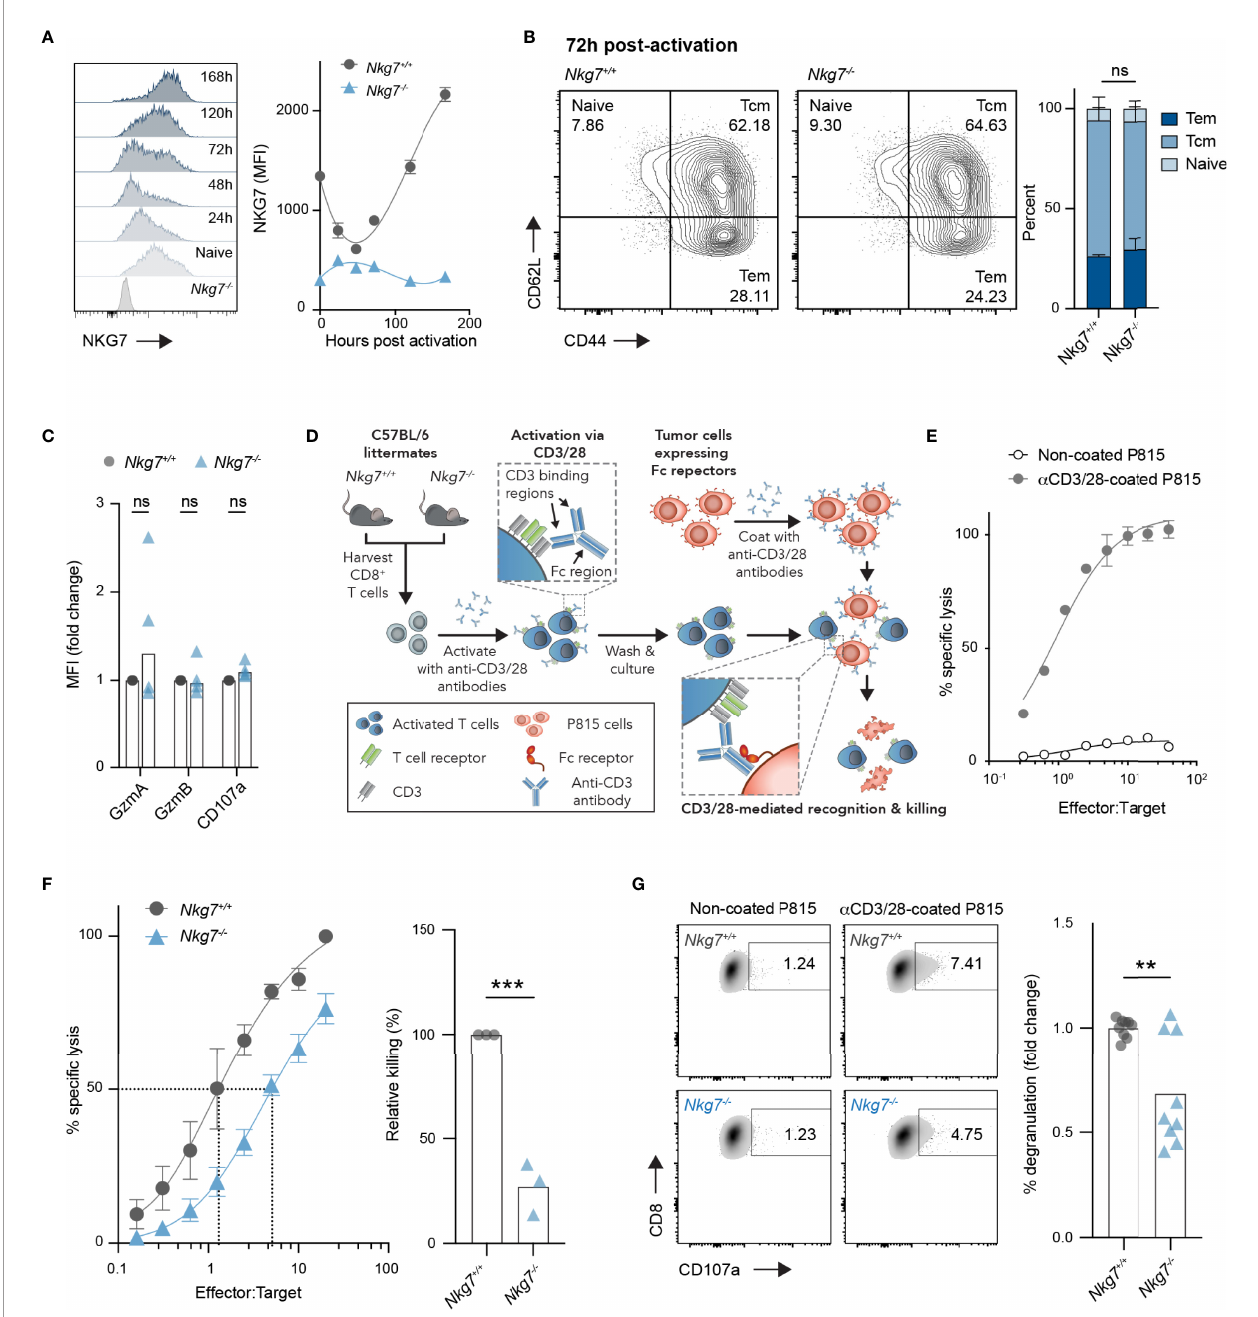
FIGURE 2 | NKG7-de fi cient CD8+ T cells undergo normal activation but exhibit reduced cytotoxicity. (A) NKG7 expression in CD8+ T cells isolated from the spleens of C57BL/6J Nkg7 +/+ or Nkg7 -/- littermates, measured by fl ow cytometry before and at indicated timepoints post-activation with anti-CD3/CD28 antibodies. (B) CD8+ T cells from (A) evaluated by fl ow cytometry 72 hours post activation and classi fi ed as naïve (CD44 - CD62L + ), central memory (Tcm; CD44 + CD62L + ) or effector memory (Tem; CD44 + CD62L - ), 2way ANOVA Sidak ’ s multiple comparisons test, n = 3. (C) Intracellular protein expression measured by fl ow cytometry 72 hours post activation, 2way ANOVA Sidak ’ s multiple comparisons test, n = 4. (D) Schematic of in vitro cytotoxicity assay. CD8+ T cells were activated as in (A) for 72 hours and co-cultured with anti-CD3/28 antibody-coated P815 tumor cells, which express high levels of Fc receptors that bind the Fc region of anti-CD3/28 antibodies. (E) Speci fi c lysis of chromium ( 51 Cr)-labelled P815 tumor cells (targets) by activated T cells (effectors) in a 4-hour co-culture as measured by chromium release at increasing effector to target ratios. (F) Speci fi c lysis of anti-CD3/28-coated P815 cells (targets) by 72 hour activated Nkg7 +/+ or Nkg7 -/- CD8+ T cells (effectors) in a 4-hour co-culture. Relative killing calculated as the relative ef fi ciency of T cells to achieve 50% speci fi c lysis of target cells, unpaired t test, n = 3. (G) Degranulation of 72 hour activated Nkg7 +/+ or Nkg7 -/- CD8+ T cells co-cultured with P815 target cells for 4 hours, measured by CD8+ T cell surface exposure of CD107a during the co-culture, detected by fl ow cytometry, unpaired t test, n = 9. All error bars show +/- SEM. ns – not signi fi cant, ** P < 0.001, *** P <